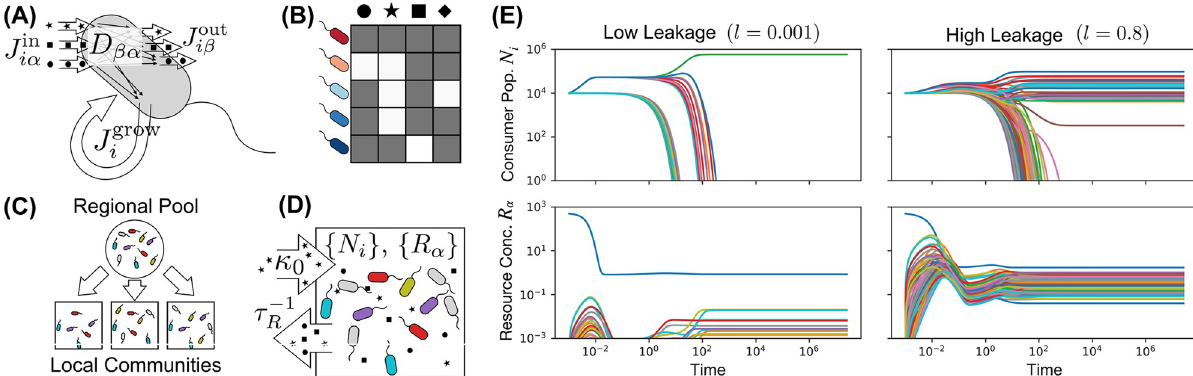
Fig 1. Microbial communities engineer complex chemical environments using a single energy source. (A) Schematic of microbe-mediated energy fluxes in the Thermodynamic Microbial Consumer Resource Model. Each cell of species i (= 1, 2, ... S ) supplies itself with energy through import of resources, generating an incoming energy flux J in for each resource type α (= 1, 2, ... M ). A fraction l α of this energy leaks back into the environment in i a the form of metabolic byproducts, with each byproduct type carrying an outgoing energy flux J out These vectors comprise a consumer matrix c . (C) A regional pool of species is randomly generated, and communities are initialized with random i α subsets of these species to simulate stochastic colonization. (D) Each community is supplied with a constant flux κ 0 of a single resource type ( α = 0), and all resources are continuously diluted at a fixed rate t (cid:0) 1 . (E) Consumer populations N and resource concentrations R α as a function of time for two i R realizations of this model, with low ( l = 0.001) and high ( l = 0.8) levels of uniform metabolic leakage (see S1 Text Section 2B for parameters).